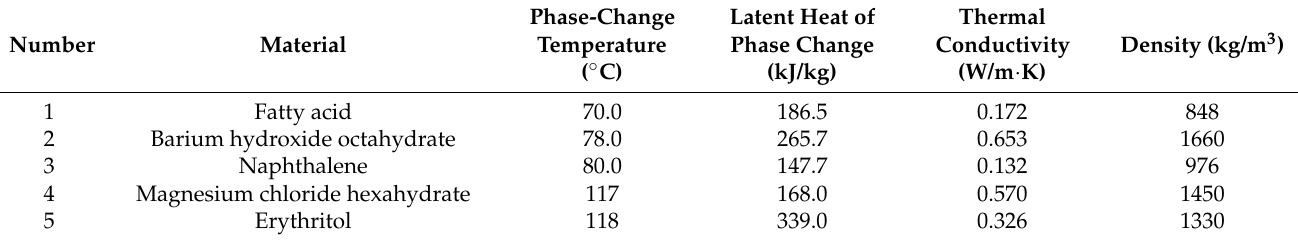
(Figure 3). The maximum deviations of the erythritol liquid-phase volume fraction were 5.72% and 6.72% when the grid number was increased from 36,036 to 53,976 or 69,936, respectively, and the influence of the grid size on the calculated results is small. The 36,036 grid scheme was finally selected for the numerical calculations by combining the calcula- tion accuracy and resources.